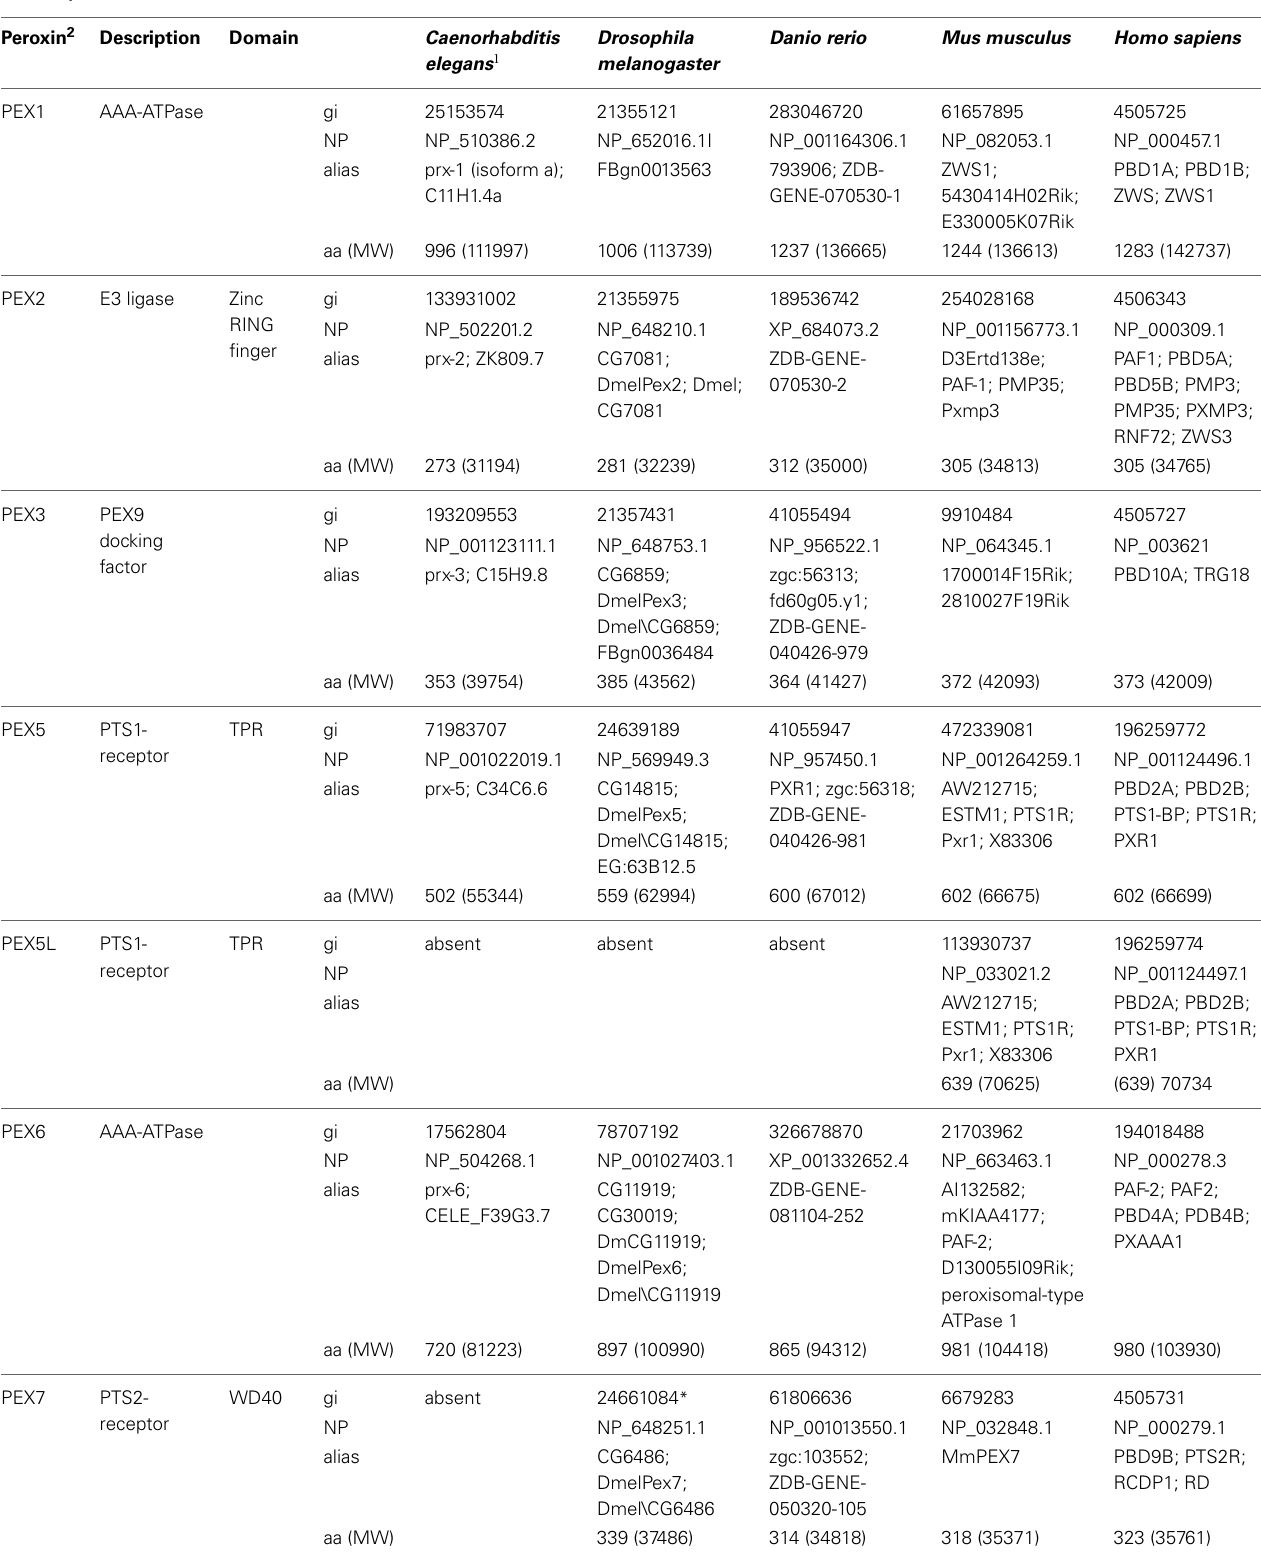
Table 1 | Overview of peroxins in animals used for peroxisomal research and in